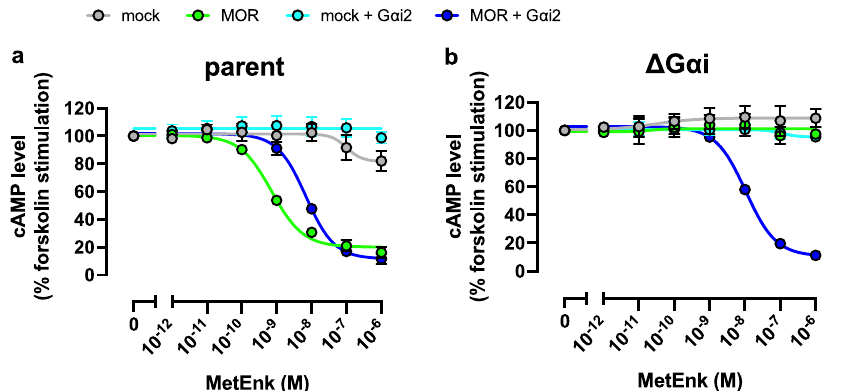
Fig. 2 Functional validation to verify successfully knocking out the G α i subunits. a , b Concentration – response curves of the GloSensor cAMP assay in parent ( a ) and Δ G α i cells ( b ). Parent and Δ G α i cells transiently expressing Glo-22F cAMP reporter with MOR and G α i2 were stimulated with 10 µ M forskolin along with indicated concentrations of MetEnk. For each experiment, forskolin-induced cAMP accumulation was set as 100%. In both fi gures, symbols and error bars represent the mean and SEM, respectively, of three independent experiments. Each experiment was performed in triplicate. Note that for many data points, error bars are smaller than the size of the symbols, and thus are not